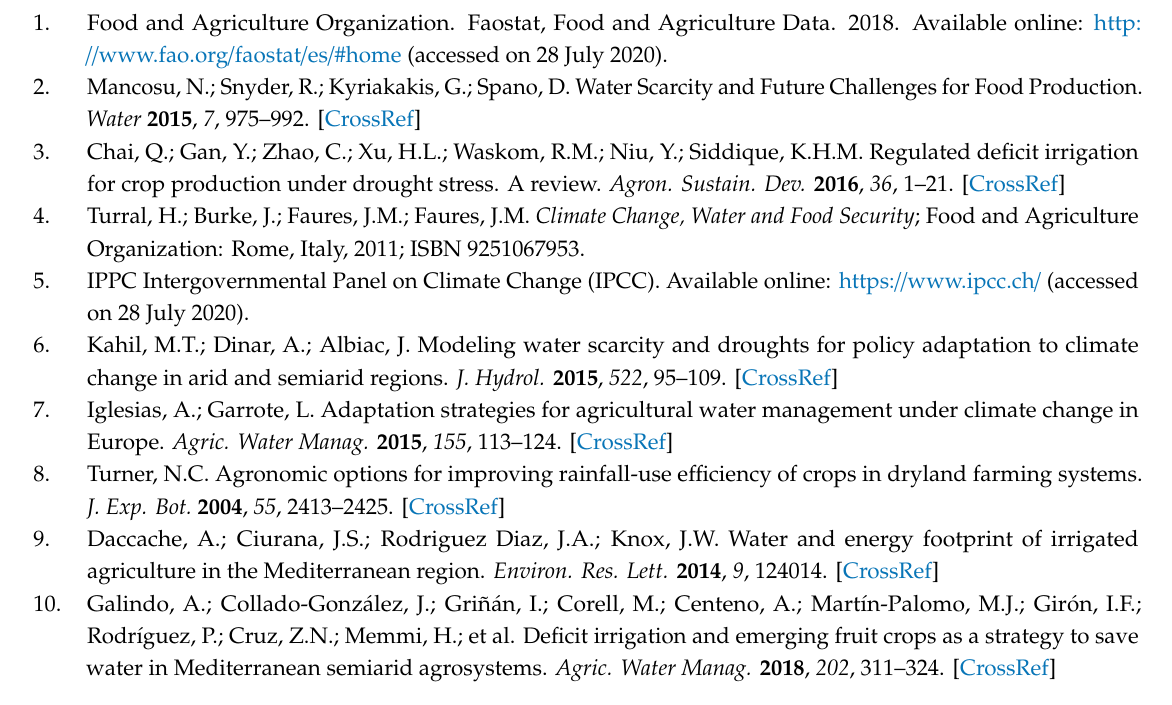
Figure S1: Temperature ( ◦ C) and relative humidity (%) values for 2018 (black line) and 2019 (red line). Table S1: E ff ect of irrigation strategy and plant type on BER yield (BER) and the fruit number of BER (No.